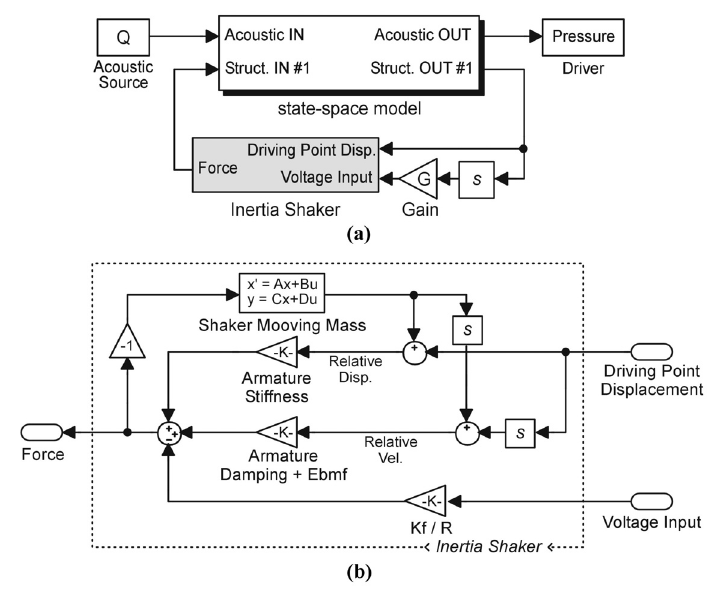
Fig. 10. Block diagrams: (a) ASAC simulation (b) detailed shaker